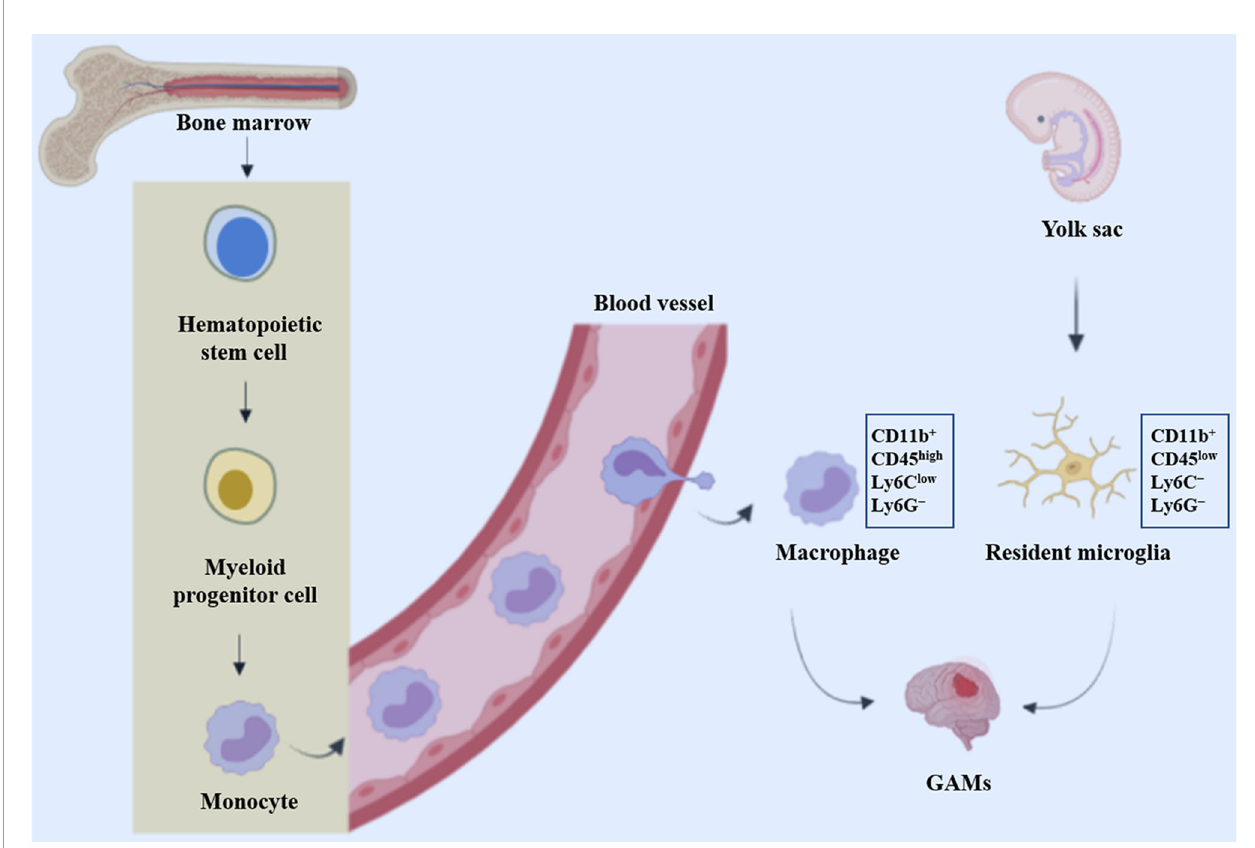
FIGURE 1 | Origin of glioblastoma-associated macrophages and microglia. GAMs represent resident microglia and bone marrow-derived macrophages (BMDM), which originate from precursor cells in the yolk sac and bone marrow